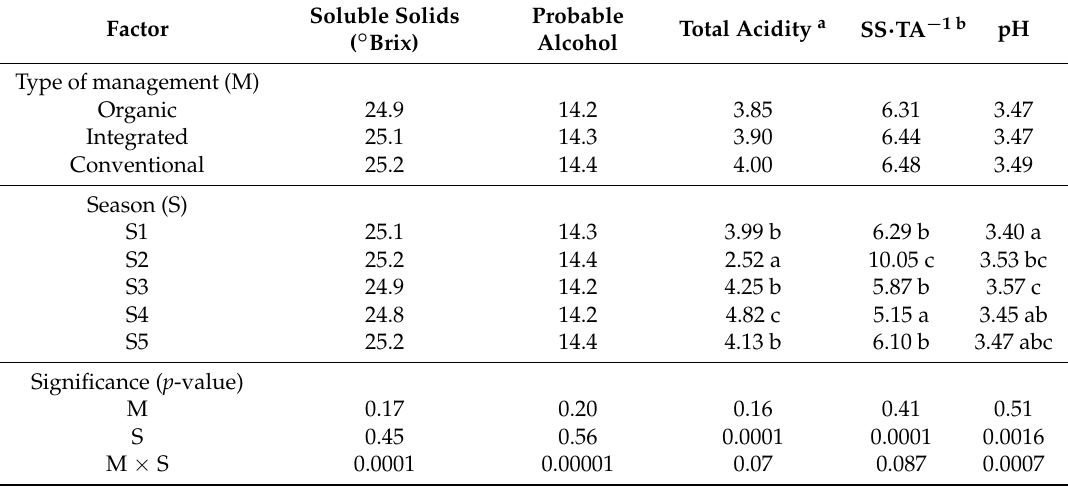
Table 3. Effect of organic, integrated, and conventional management on berry components in Cabernet Sauvignon grapevines evaluated during 5 consecutive